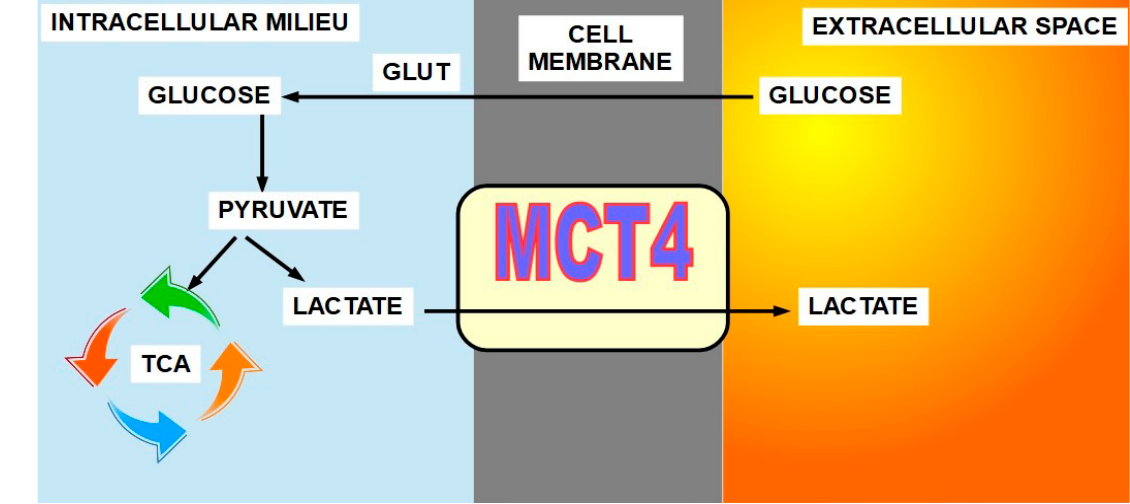
Figure 6. Lactate extruder function of MCT4. Lactate originates from the enzymatic glycolysis of glucose introduced from the extracellular space with the mediation of glucose transporters (GLUTs). MCT4 is the main lactate exporter, while MCT1 imports lactate into the oxidative cells participating in the lactate shuttle.